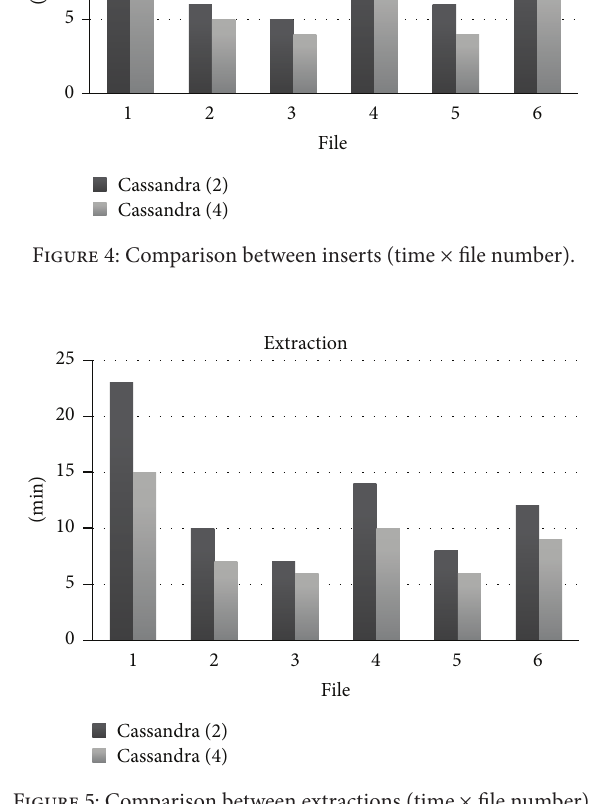
Figure 5: Comparison between extractions (time × file